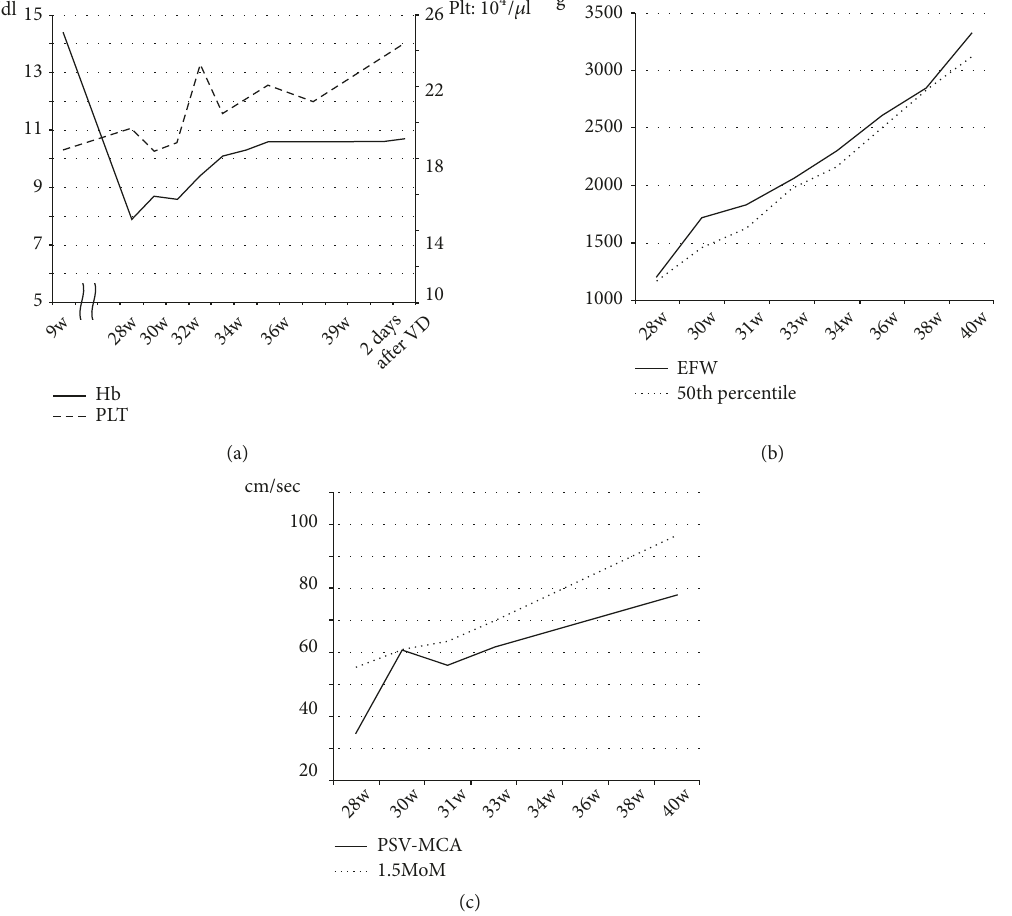
Figure 1: Clinical data during pregnancy and delivery. (a) Transition of hemoglobin concentration and platelet count from an early stage of pregnancy to delivery. Solid line, hemoglobin; dotted line, platelets. (b) Transition of fetal estimated weight (EFW). Solid line, EFW; dotted line, 50th percentile. (c) Transition of middle cerebral artery peak systolic velocity (MCA-PSV). Solid line, PSV-MCA; dotted line; 1.5 MoM.